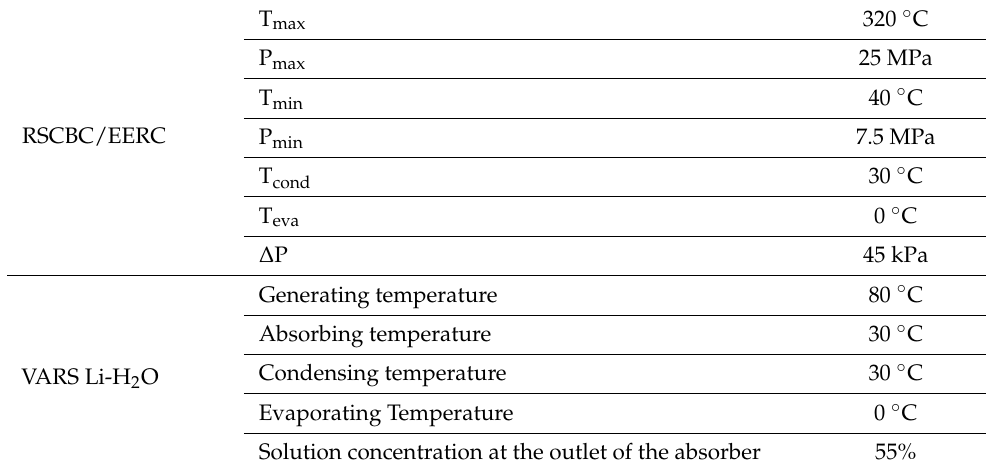
Table 10. Operating conditions considered in simulations.